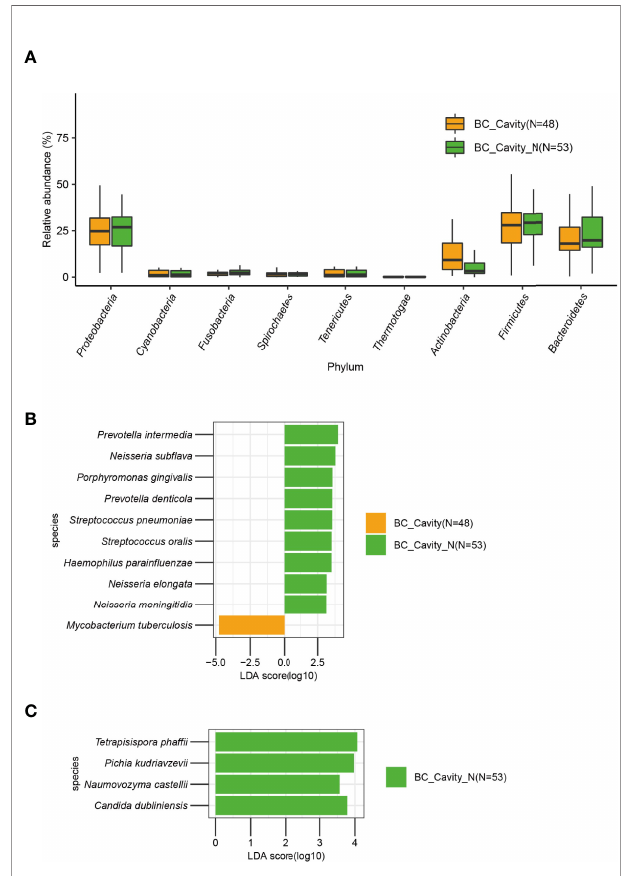
FIGURE 5 | In BC patients, the presence or absence of chest cavity was signi fi cantly associated with the lung microbiome. In the BC group, Actinobacteria was signi fi cantly enriched in patients with chest cavity (A) . Bacteria (B) that were signi fi cantly differentially enriched in BC patients with or without chest cavity were identi fi ed by LEfSe. Fungi that were signi fi cantly differentially enriched in the BC_Cavity_N group were identi fi ed by LEfSe (C)